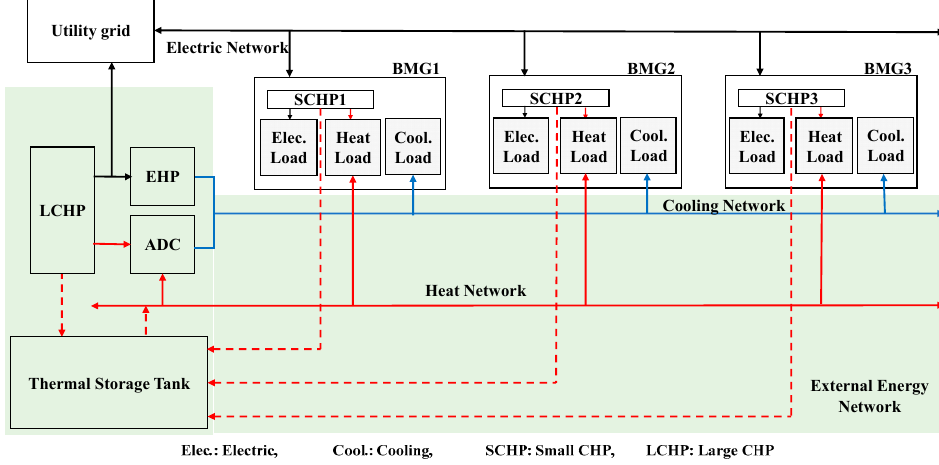
Figure 1. Schematic diagram of electricity, heating, and cooling networks in the proposed system.